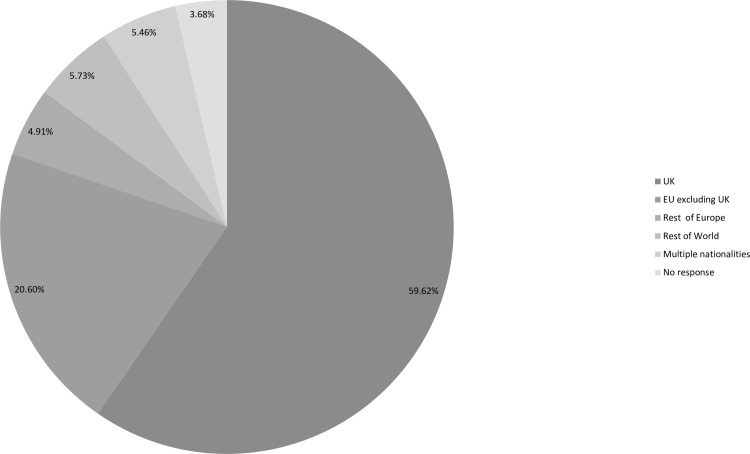
Nationality profile of participants (S2 Table).